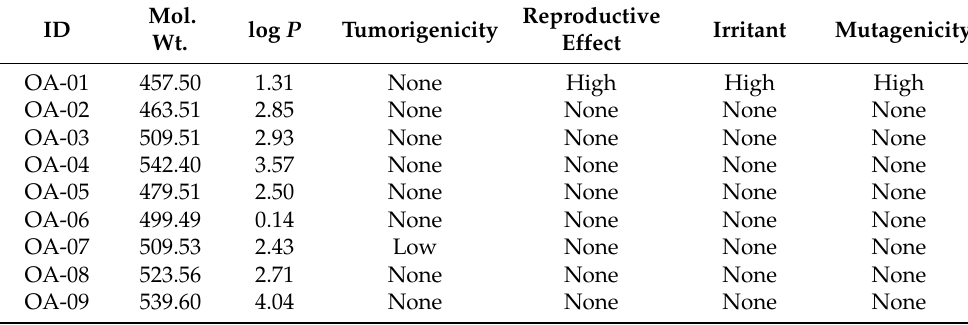
Table 1. Predicted toxicity properties of screened SCP-2